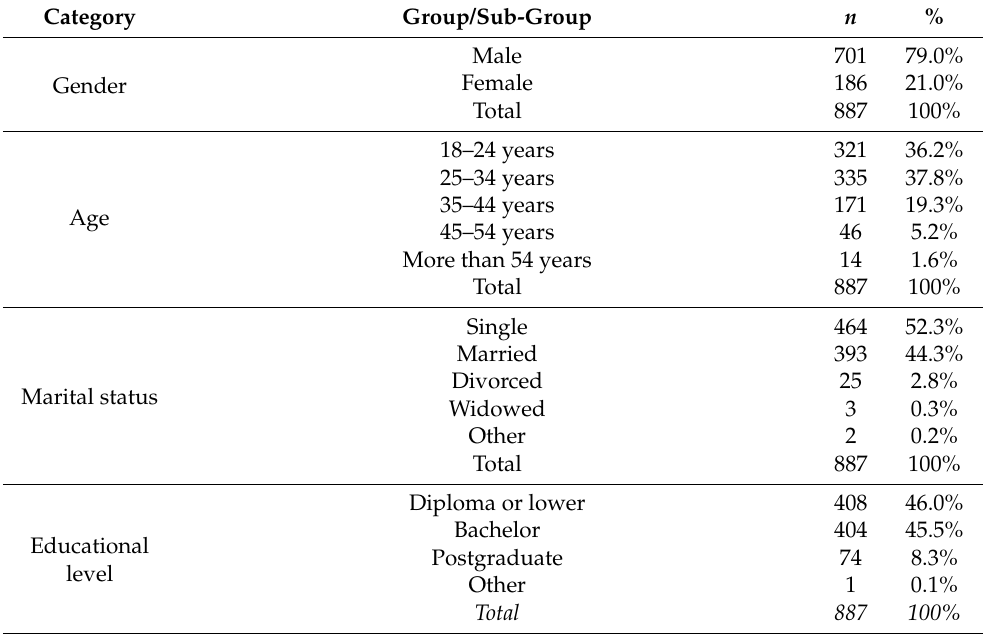
Table 1. Demographics and characteristics of surveyed sample ( n =